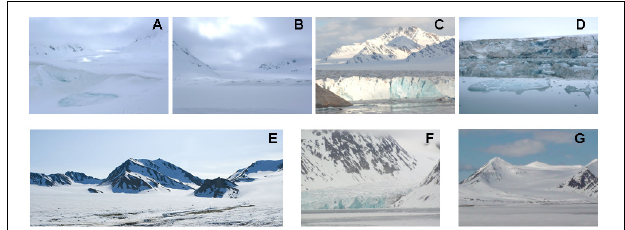
(C) Kongsvegen (KGV); (D) Kronebreen (KNB); (E) Brøggerbreen (BGN); (F) Ytre Norskøya, Hamiltonbukta (YTRE); (G) Poolepynten,